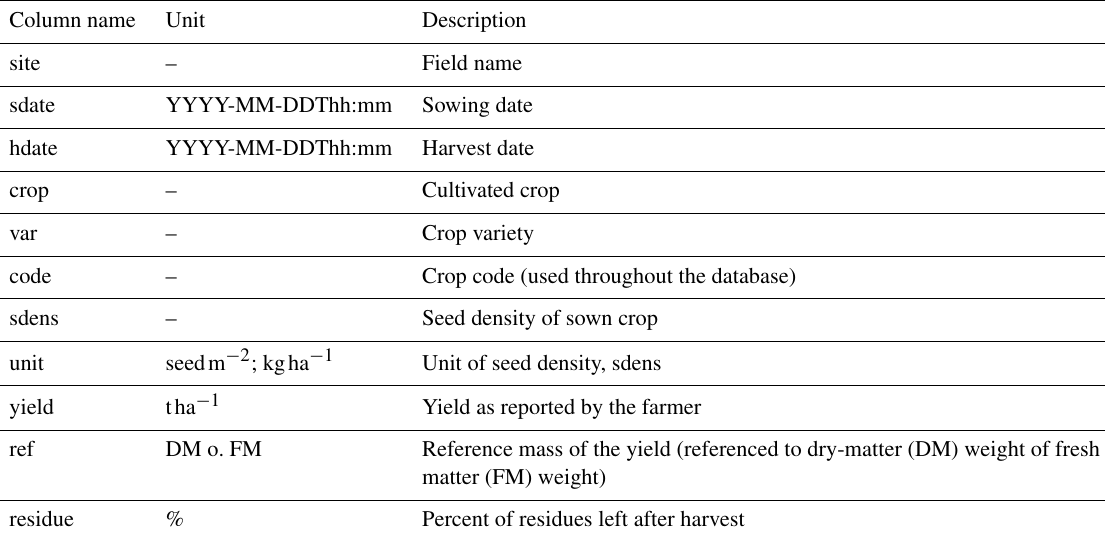
Figure 7. Folder structure of the dataset. Table 6. Determined variables and description of the field cultivation data files (cultivation.csv) including farmer reported yield.